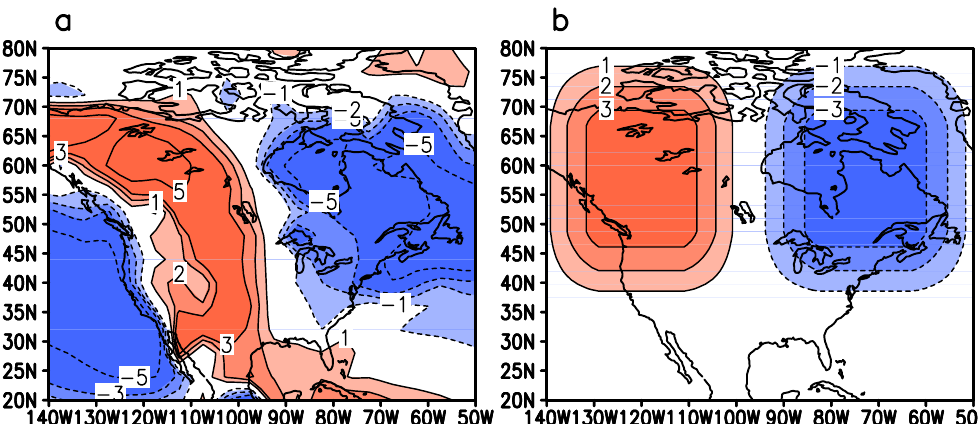
Fig. 2. (a) Deviation of observed summer surface air temperature from the zonal average over the CLIMBER-2 sector corresponding to North America. (b) Temperature correction added to the interpolated CLIMBER-2 temperature in the SEMI